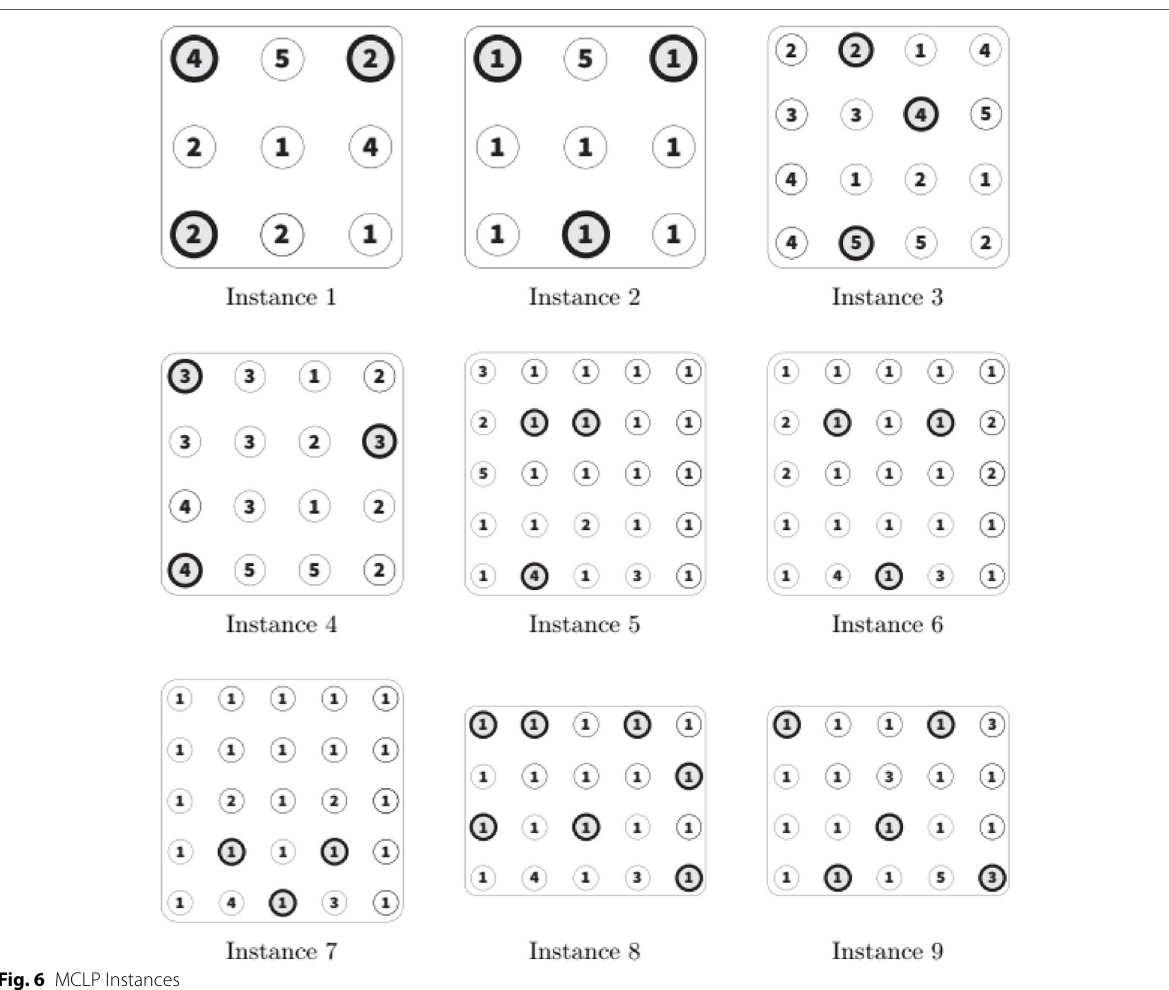
Fig. 6 MCLP Instances